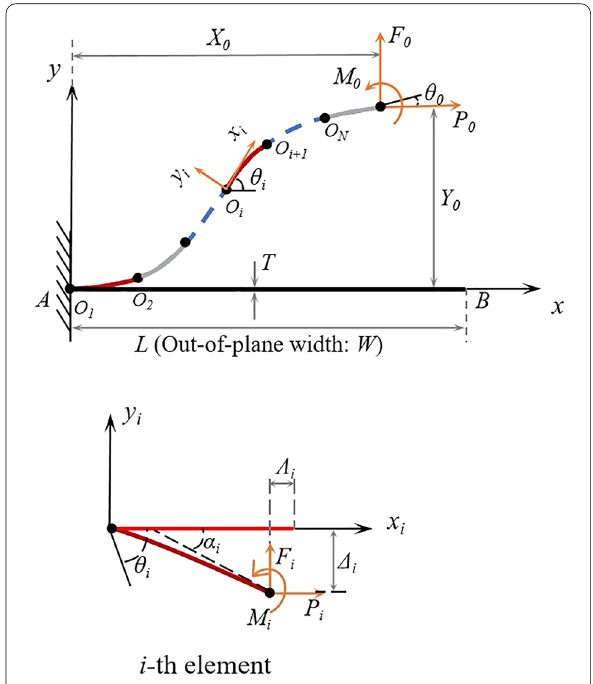
Figure 4 Discretization of the